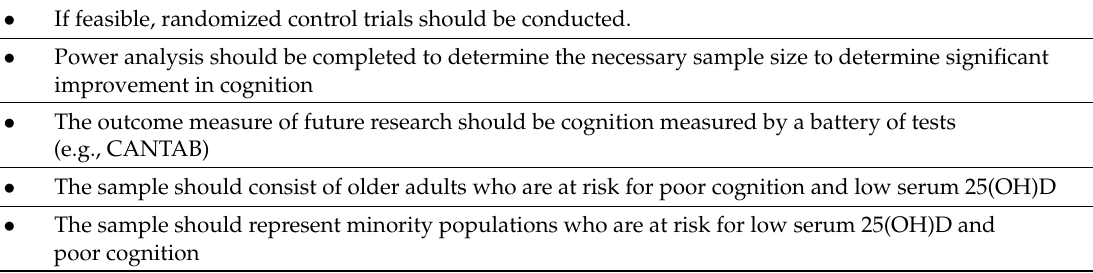
Table 5. Key points regarding future research on serum 25(OH)D and